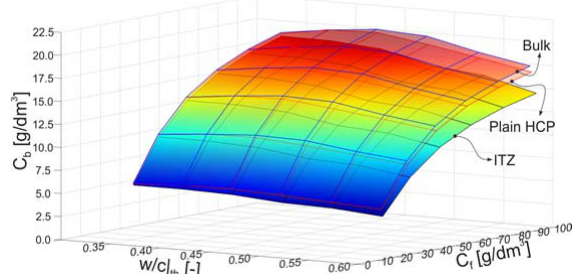
Figure 3. Binding isotherm surfaces of ITZ, bulk paste and plain